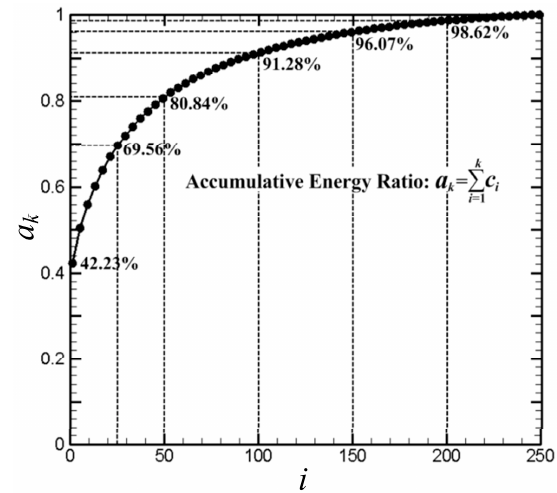
Figure 13. Accumulative energy ratio spectrum (accumulative energy ratio vs. rank).